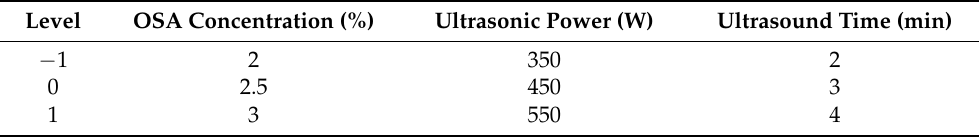
Figure 1. Schematic diagram of Pickering emulsion prepared by shear and ultrasound. Table 1. The factors and levels of response surface